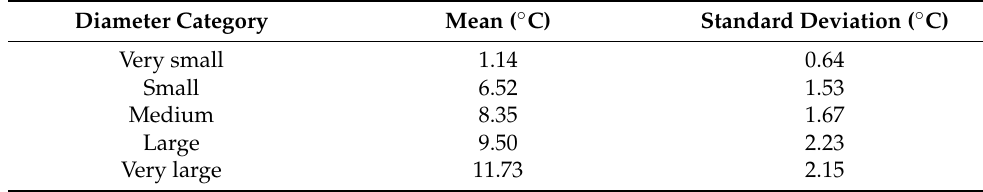
Figure 6. Temperature differences ( ∆ T) for each sample category.